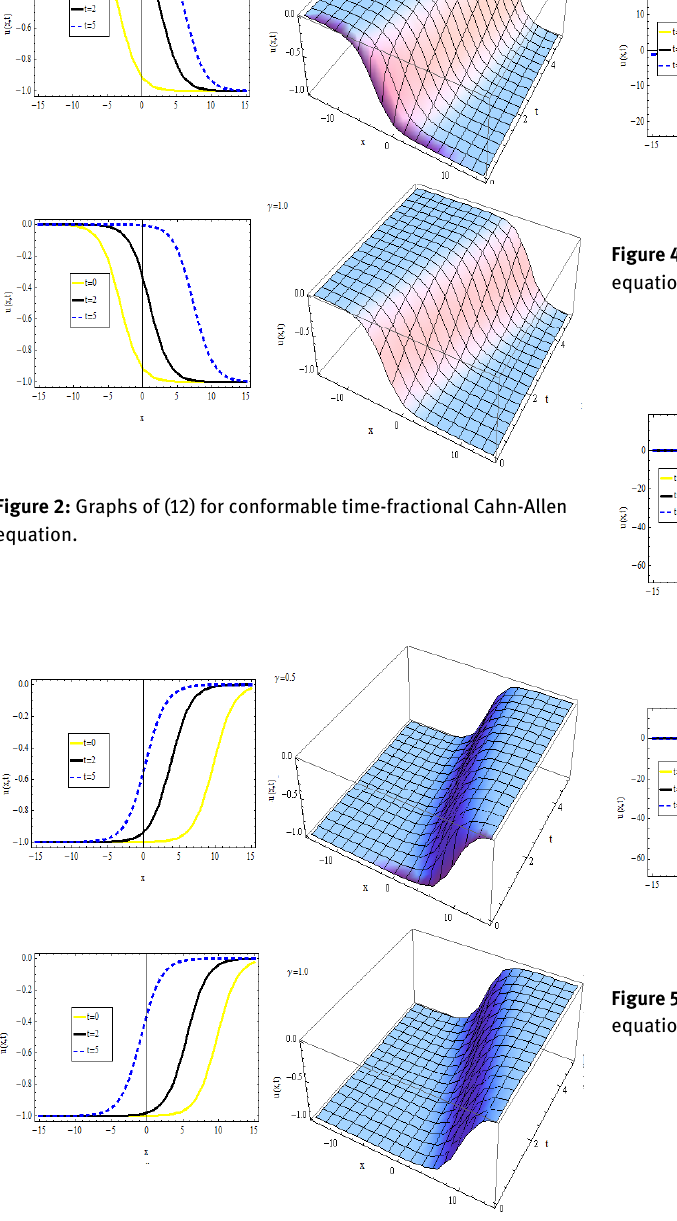
Figure 3: Graphs of (13) for conformable time-fractional Cahn-Allen equation.